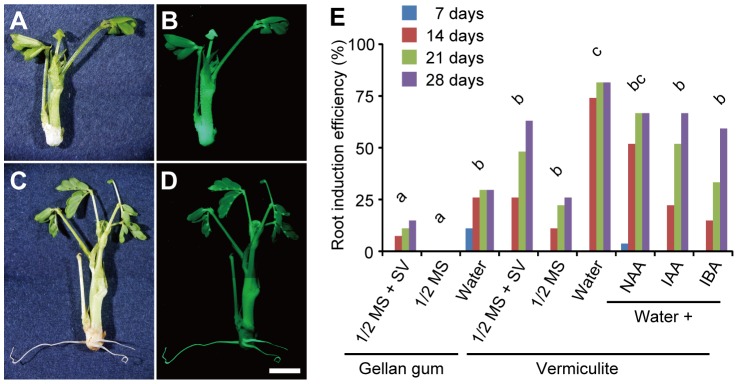
Optimization of root induction conditions.A–D. Bright-field (A, C) and green fluorescent (B, D) images of a transformed shoot before (A, B) and after (C, D) 14 days of cultivation in irrigated vermiculite. Scale bar, 5 mm. E. Comparison of root induction conditions (n = 27). A statistical analysis was conducted using the frequencies at 14 days of cultivation. Significant differences (P<0.05 by Fisher's exact test with Holm's P-value adjustment) were observed between two groups that do not share the same lowercase letter. 1/2 MS, half-strength MS salts; SV, 2% sucrose and 1× Gamborg's vitamins.